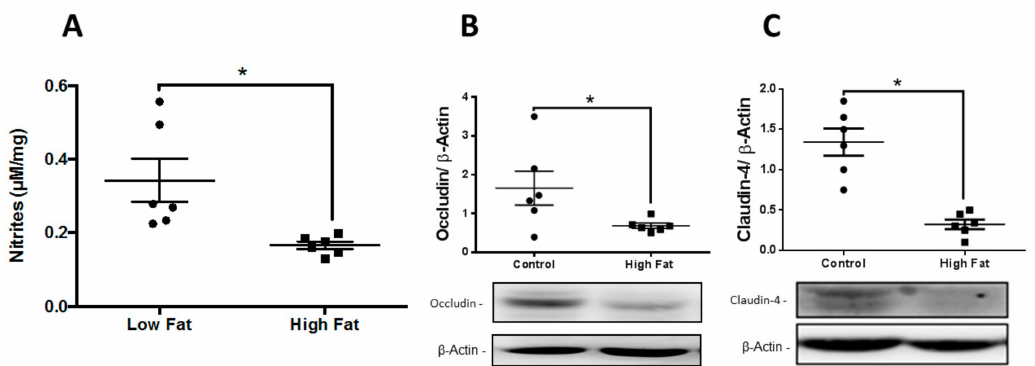
Figure 1. NO and occludin reduction on type 2 diabetic: Skin evaluation of NO levels ( A ); Western blot for occludin ( B ); and Western blot for claudin-4 ( C ). Data represent the mean ± SEM, n = 6 per group, * p < 0.05, Student- t test.